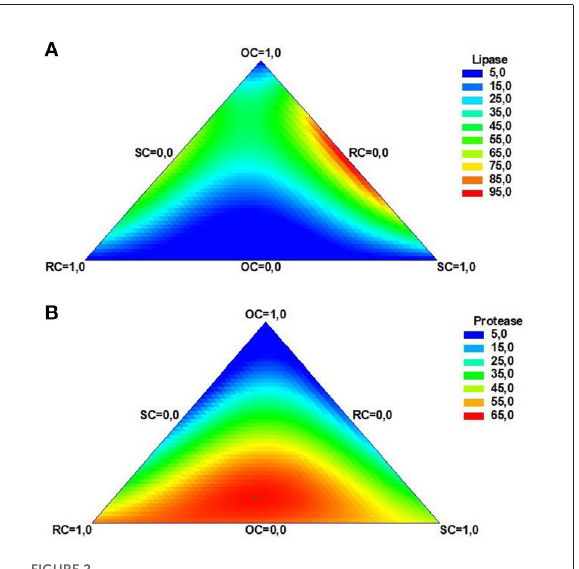
FIGURE2 Contour plots for the dependent variables obtained in the simplex centroid mixture design. (A) Lipase and (B) protease.